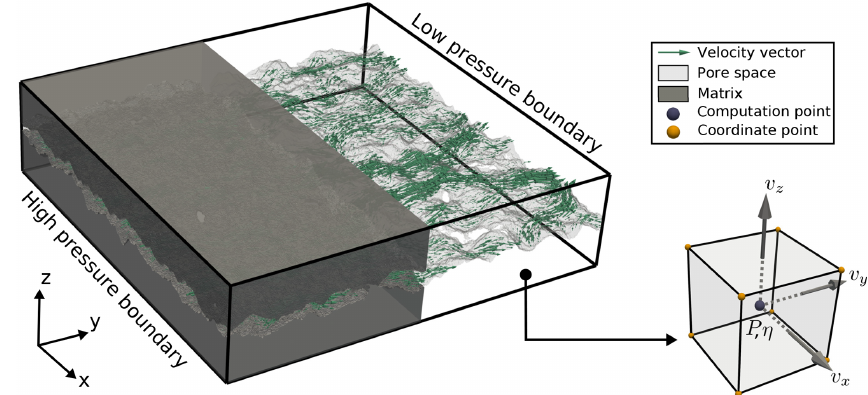
Figure 3. Model setup employed in the numerical simulations. The two boundaries where the pressure gradient is applied are indicated. The green velocity vectors are used for the computation of v and scaled according to their magnitude. The subfigure illustrates the staggered-grid discretization scheme of a single voxel.